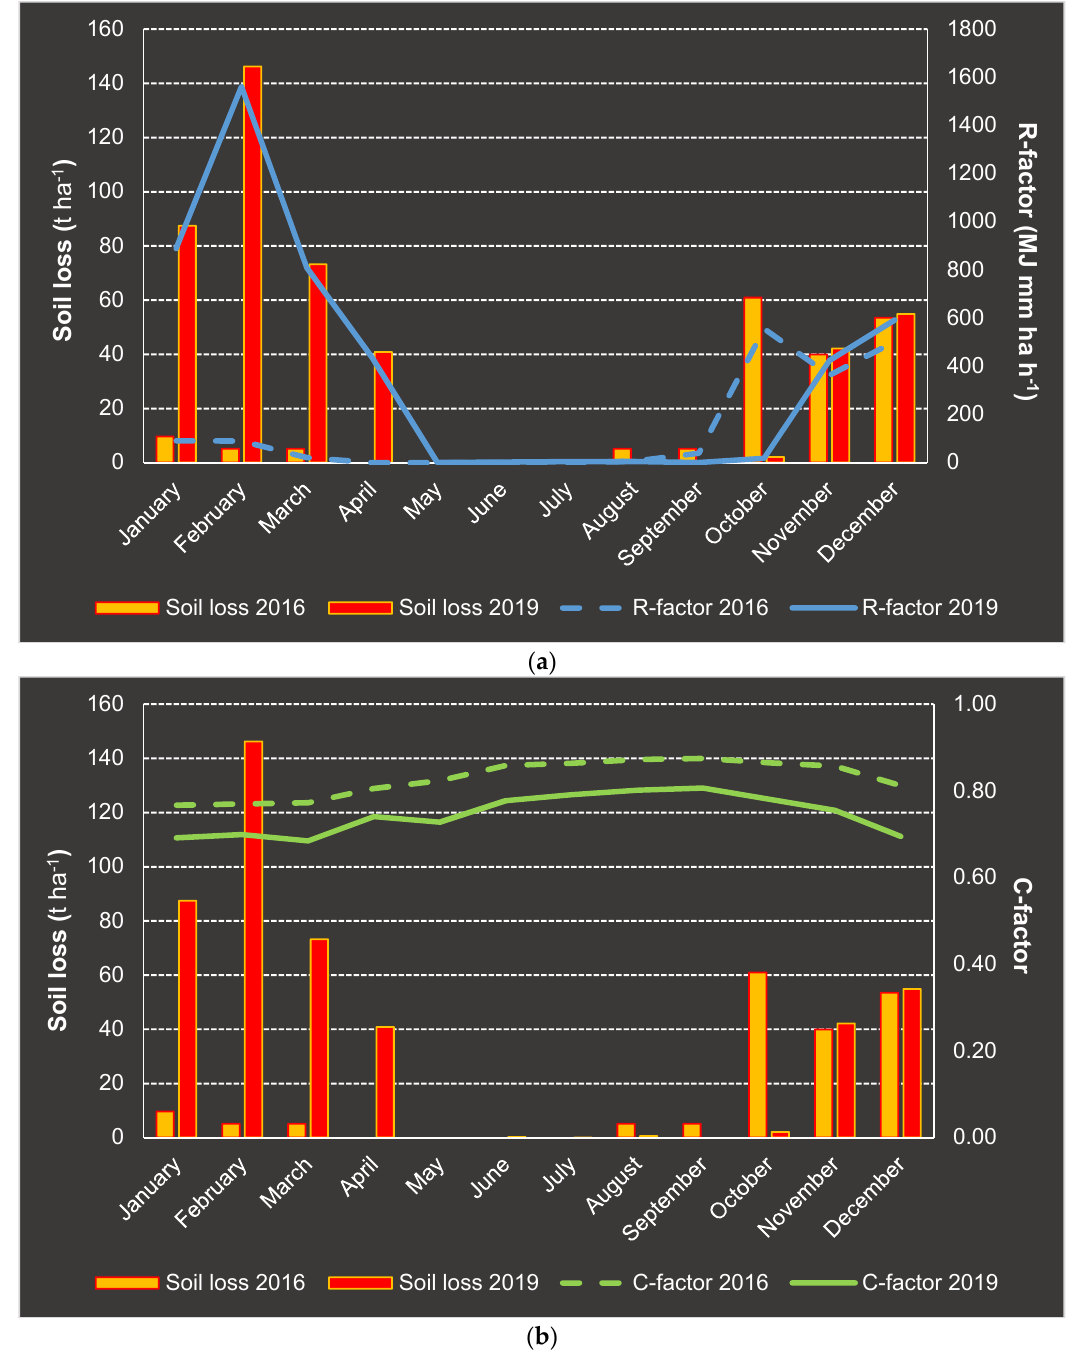
Figure 7. Monthly variation of mean soil loss rate in 2016 and 2019 compared to this one of: ( a ) mean rainfall erosivity (R-factor); ( b ) mean cover management (C-factor).